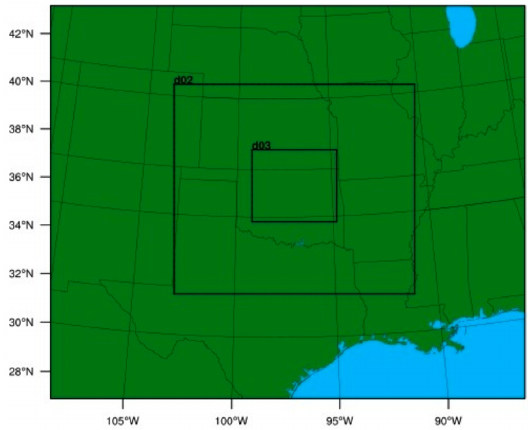
Figure 3. Three nesting domains with 25, 5, and 1 km grid spacing in WRF simulation.